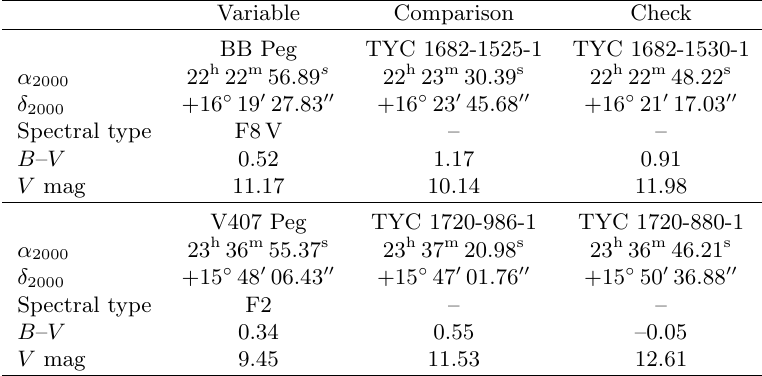
Table 1. Observational properties of variable, comparison, and check stars. Variable